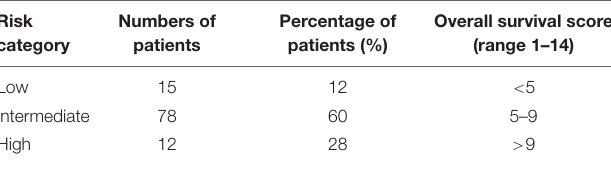
TABLE 1 | Overall survival score risk categories of primary HCC patients after curative surgical